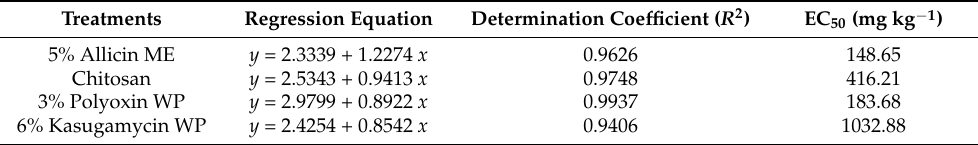
Table 2. The toxicity of allicin, chitosan, polyoxin and kasugamycin against Sphaerotheca sp.